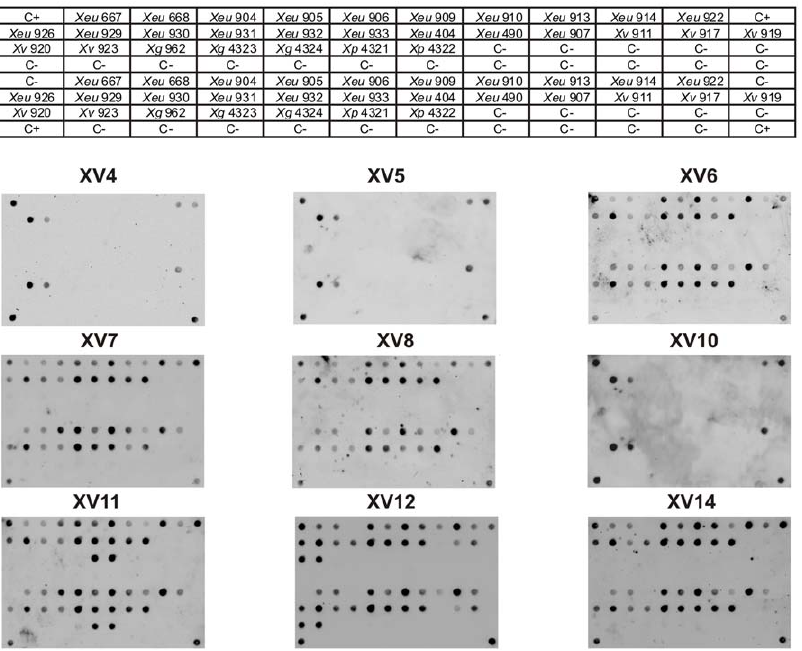
Figure 3. Dot blot validation of selected probes. Nine probes were evaluated with total DNA from a collection of BSX, consisting of 19 Xeu , five Xv , three Xg and two Xp strains. Probability values, obtained with a customized MATLAB algorithm for the automatic data analysis, are detailed in Table 3.